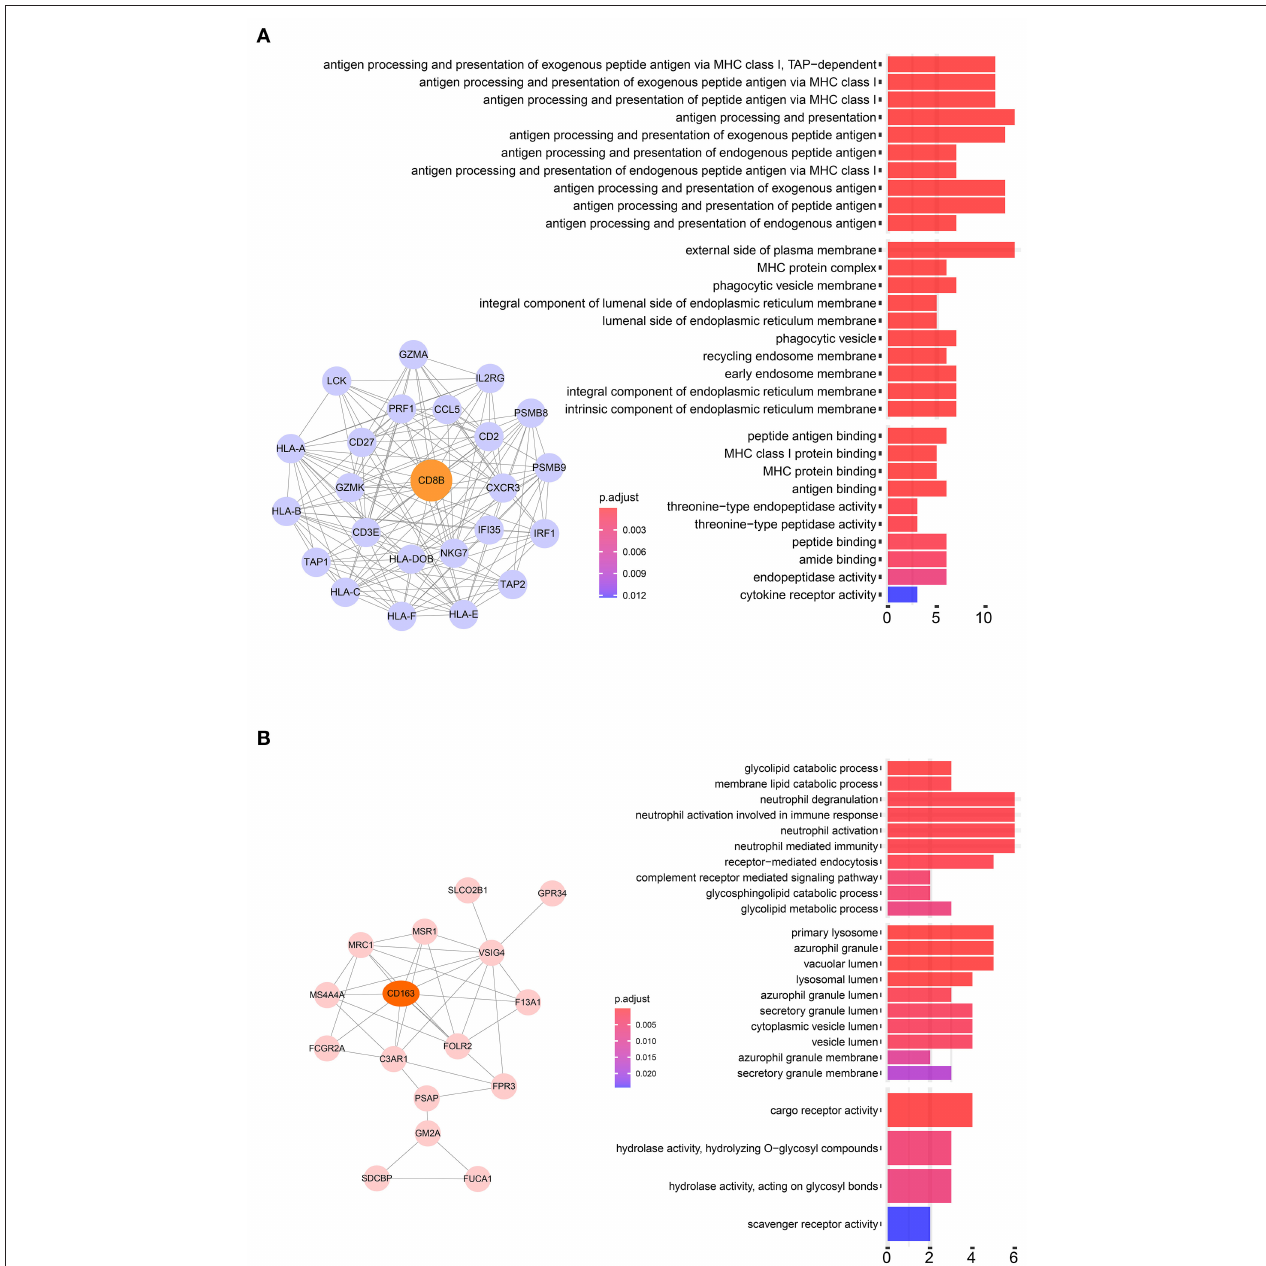
FIGURE 3 | (A) Pathway analysis of 24 negatively correlated co-expressed genes in M2 macrophages in the purple module. These genes were most significantly enriched in the antigen processing and presentation of exogenous peptide antigen via MHC class I, which suggested a declining effect on tumor antigen peptide process. (B) Pathway analysis of 16 negatively correlated co-expressed genes in M2 macrophages in the brown module. These genes were most significantly enriched in neutrophil activation involved in immune responses.